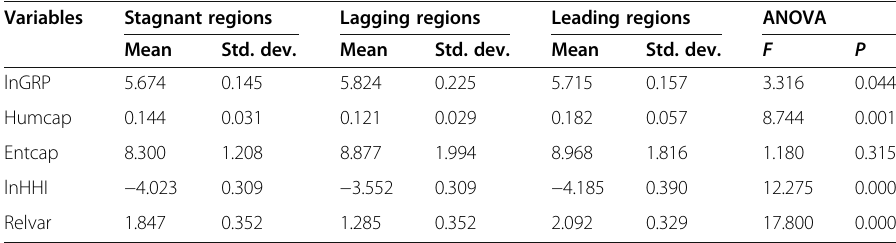
Table 4 Comparison of group means Variables Stagnant regions Lagging regions Leading regions